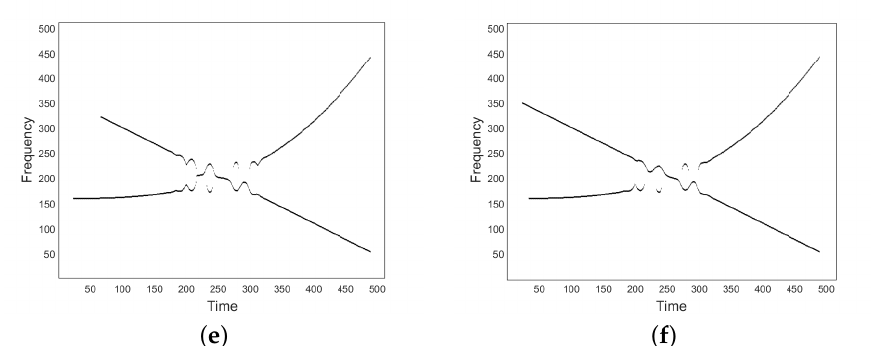
Figure 10. ( a ) Spectrogram of the AM-FM two-component signal as in Equation (29). ( b ) Spectrogram of the AM-FM two-component signal as in Equation (30). ( c ) IF curves of ( a ) provided by the proposed method. ( d ) IF curves of ( b ) provided by the proposed method. ( e ) IF curves estimated from spectrogram maxima in ( a ). ( f ) IF curves estimated from spectrogram maxima in ( b ).